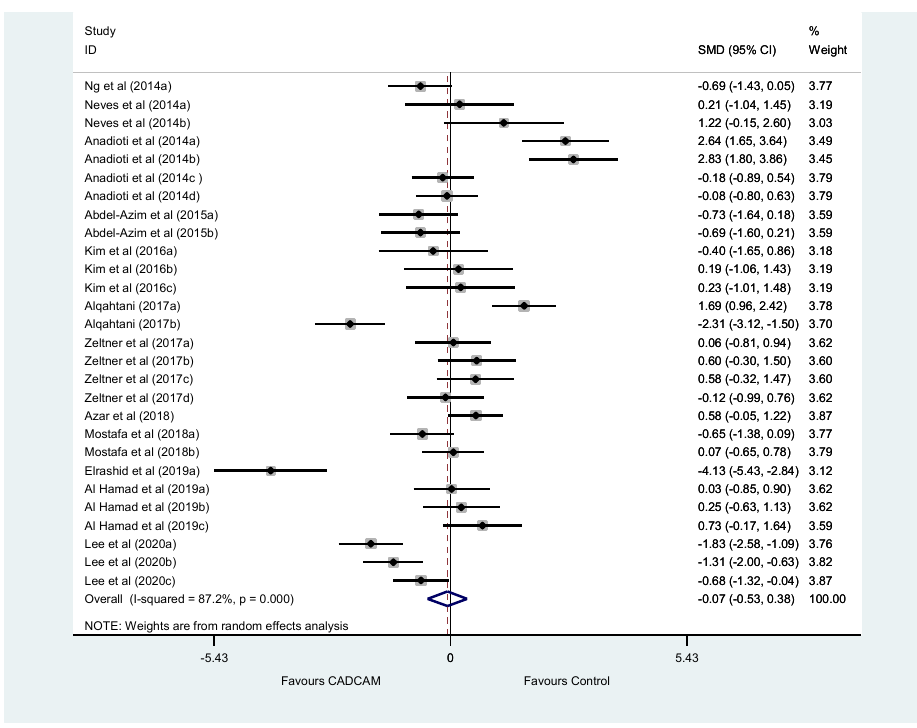
analysisOverall (I-squared = 87.2%, p = 0.000) NOTE: Weights are from random effects